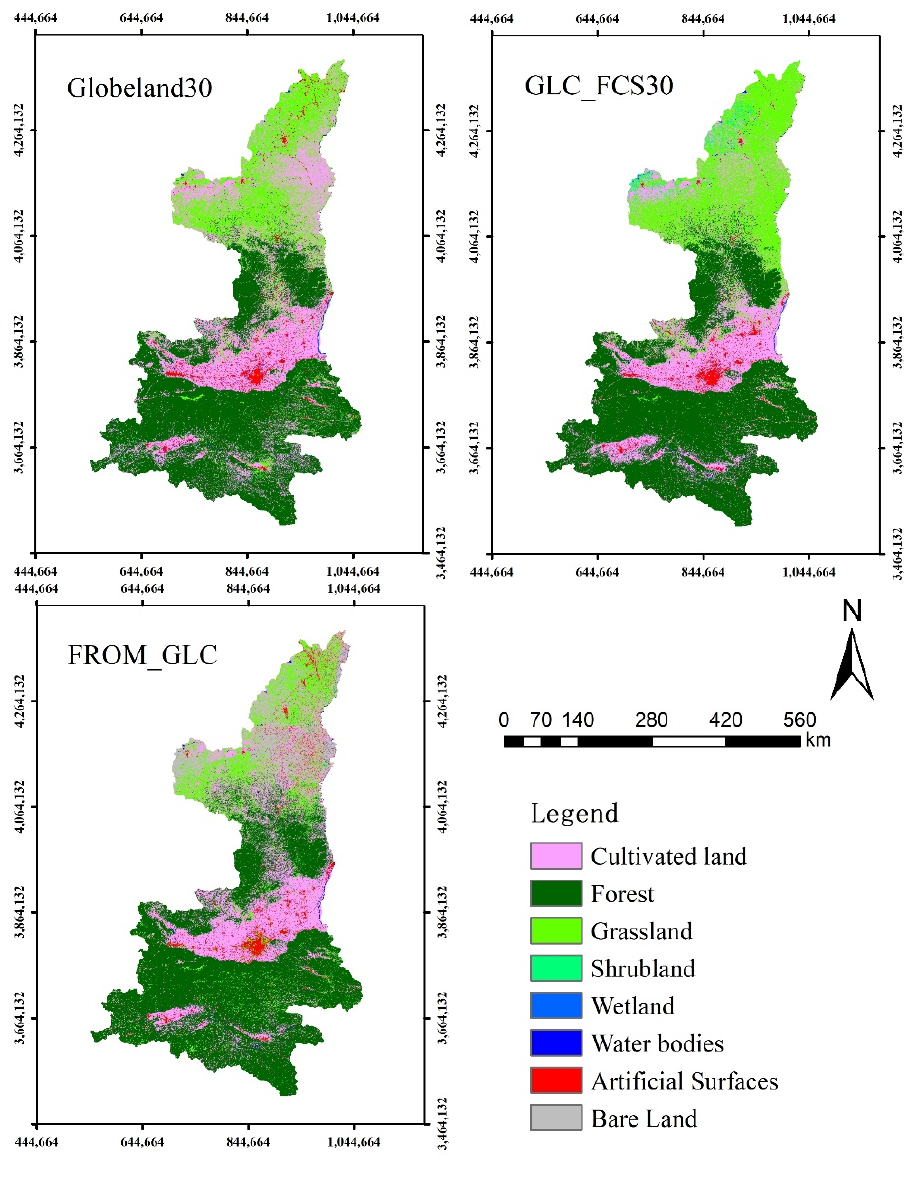
Figure 1. The base land cover maps of Shaanxi province, China, in 2010 ( a ) and 2020 ( b ). GlobeLand30 (http://www.globallandcover.com/home_en.html (accessed on 10